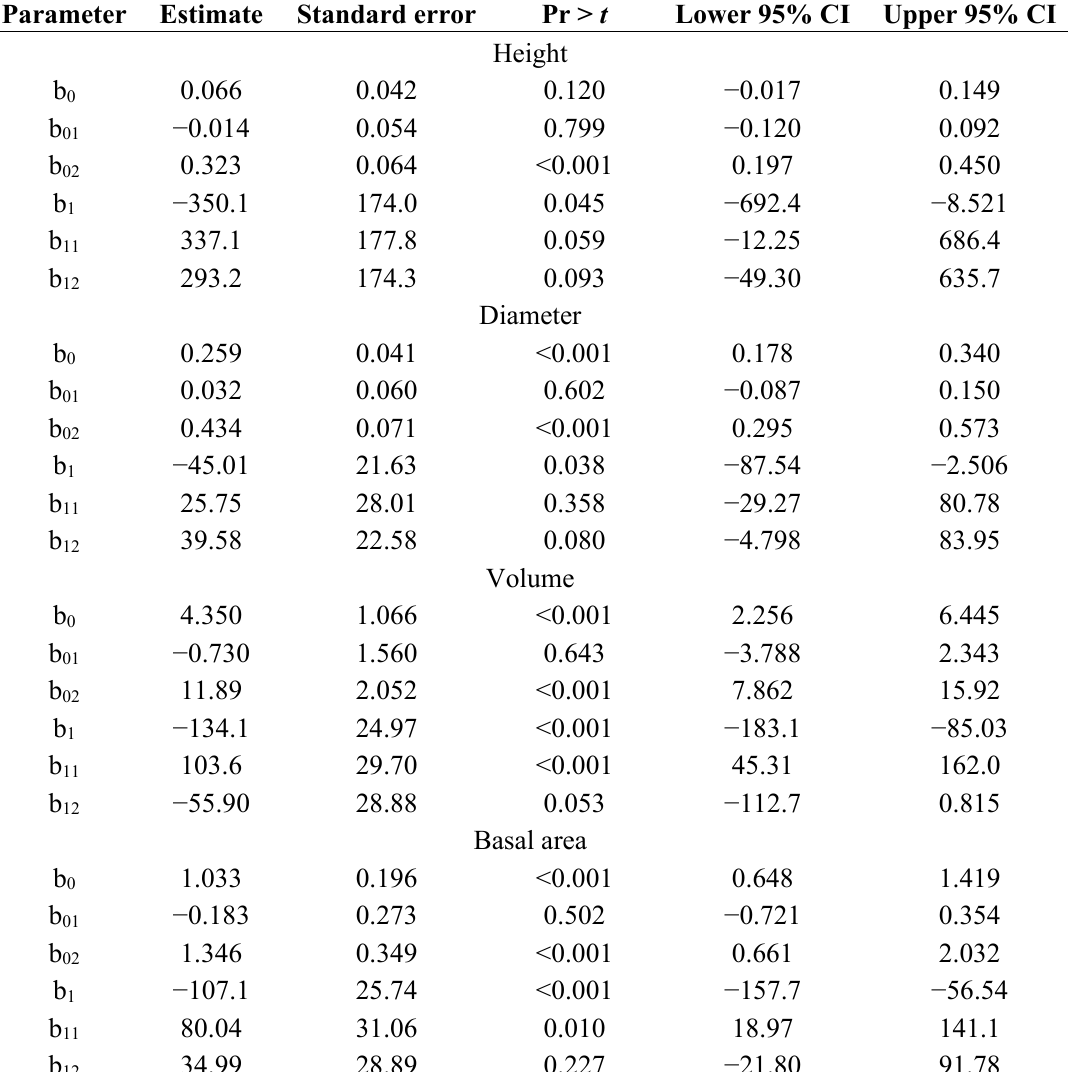
Table 7. Parameter estimates, standard error, t values, lower and upper 95% confidence intervals (CI) for the height, diameter, volume and basal area growth response to increasing nitrogen dose functions. b 0 is the asymptote for soil group 3, b 01 and b 02 are adjustments to b 0 for soil groups 1 and 2, respectively. b 1 is the shape parameter for soil group 3, b 11 and b 12 are adjustments to b 1 for soil groups 1 and 2,